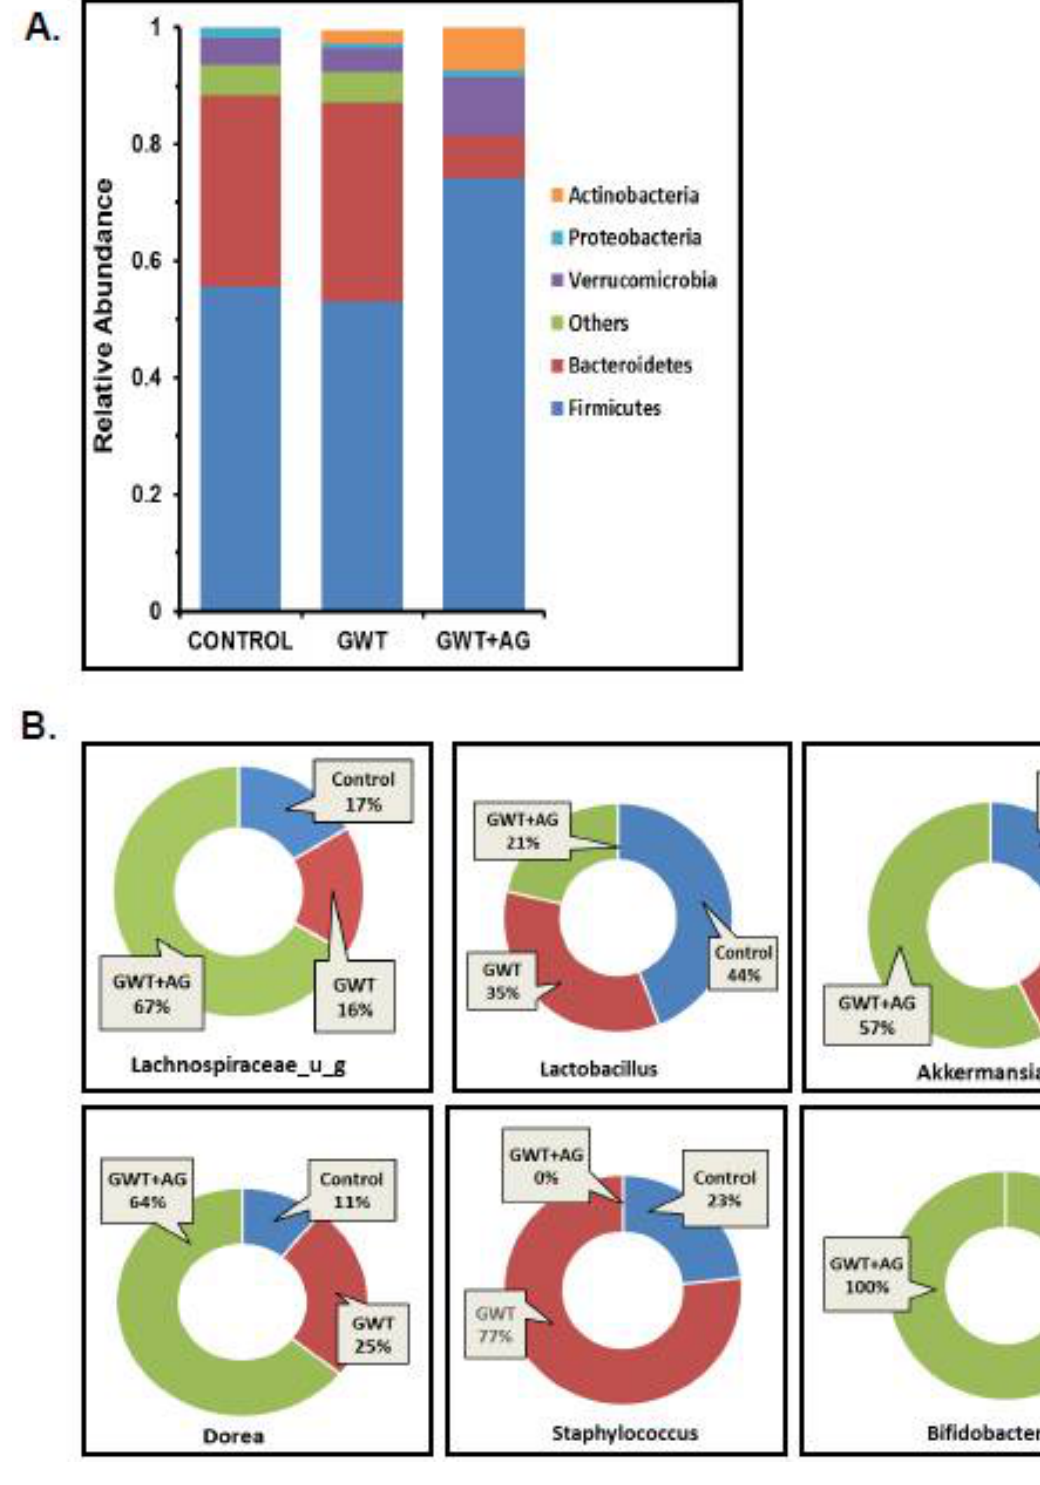
Figure 1. Gulf War (GW) chemical exposure results in alteration of mouse gut bacteriome, while andrographolide (AG) treatment helps in restoration of normal microbiome. ( A ) The relative abundance of the bacteriome is presented by group average at the phylum level for CONTROL (mice treated with vehicle only), GWT (GW chemical exposed mice), and GWT+AG (mice co-exposed to both GW chemicals and AG) groups. ( B ) Graphical representation of six significantly altered bacteria at the genus level. The percentage abundance of (i) Lachnospiraceae_u_g , (ii) Lactobacillus , (iii) Akkermansia , (iv) Dorea , (v) Staphylococcus , (vi) Bifidobacterium has been calculated and presented as the mean for CONTROL, GWT, and GWT+AG